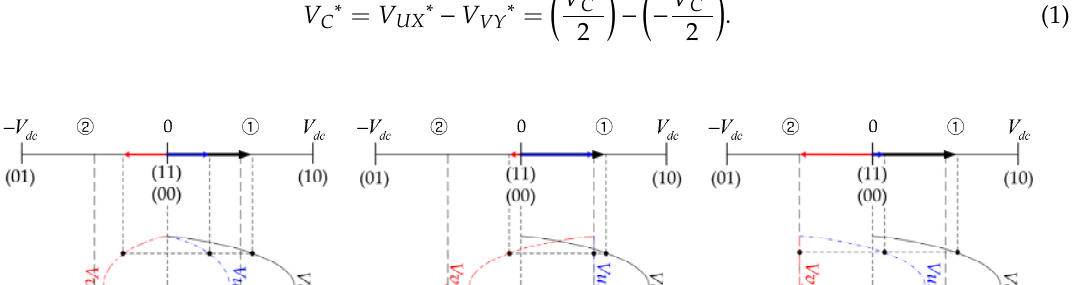
Figure 3. Switching references according to the PWM methods: ( a ) conventional carrier ‐ based sinusoidal pulse ‐ width modulation (CB ‐ SPWM), ( b ) proposed discontinuous PWM (DPWM) with upper clamping mode (UCM), and ( c ) proposed DPWM with lower clamping mode (LCM).